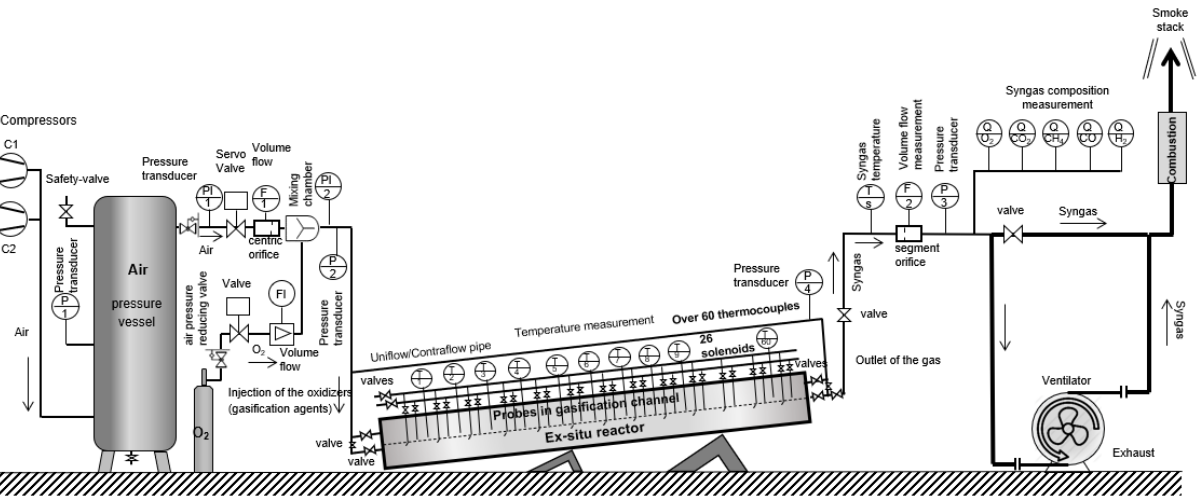
Figure 3. Experimental gasification equipment (modified after [20]).